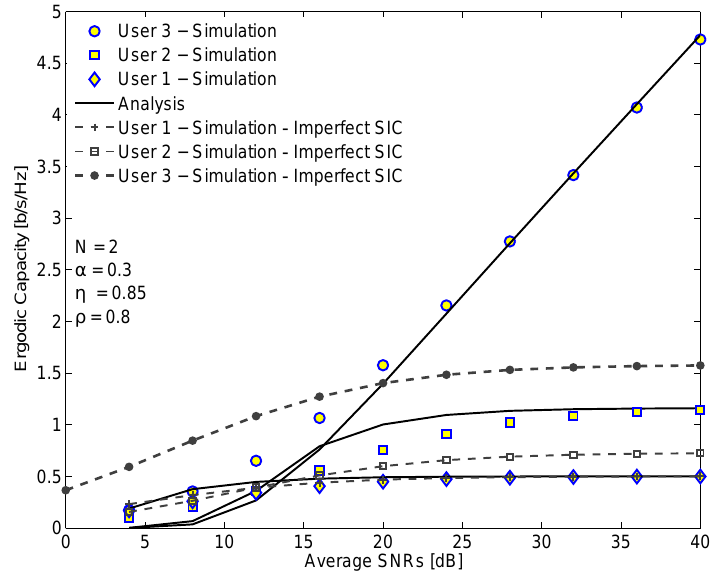
Figure 7. The ergodic capacity of each user and the ergodic capacity in EH-NOMA relaying system versus the average